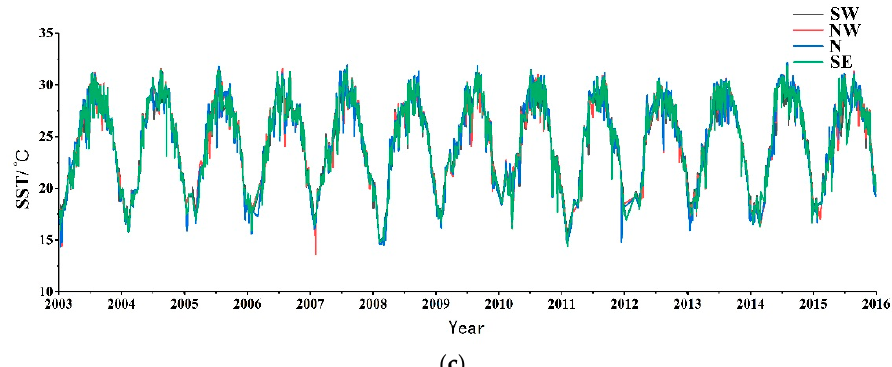
Figure 2. Experimental data: ( a ) Live coral cover (LCC) records from 2004 to 2015; ( b ) average monthly sea surface temperature (SST) around Weizhou Island during October 2012; ( c ) daily SST of the study sites from 2003 to 2015. SW: South-west; NW: North-west; N: North; SE: South-east.